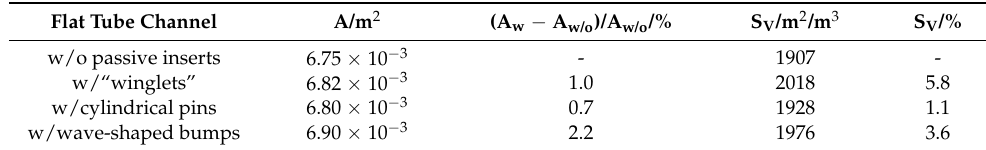
Table 4. Heat transfer surface A and specific surface for flat tube channels with and without passive